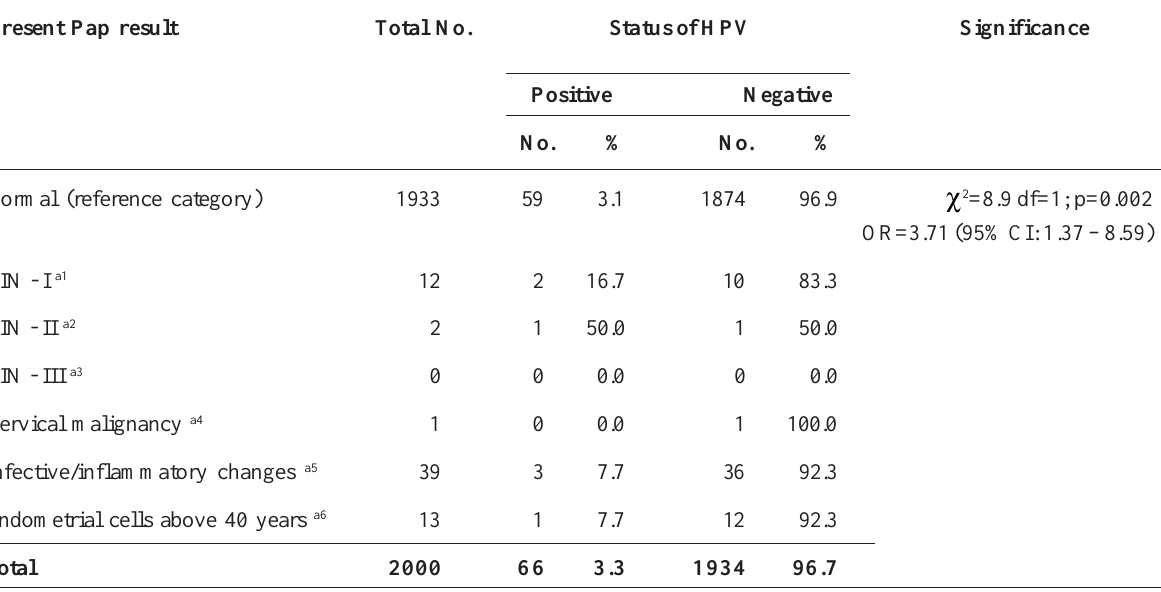
Table 3. Distribution of HPV status by Pap smear